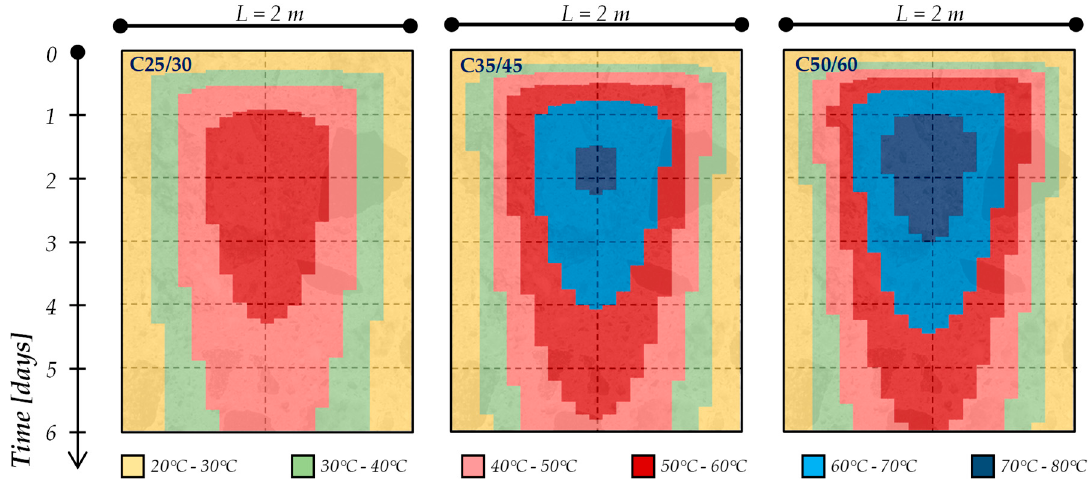
Figure 6. Time evolution of temperatures in the 2-m concrete elements during the hydration processes.